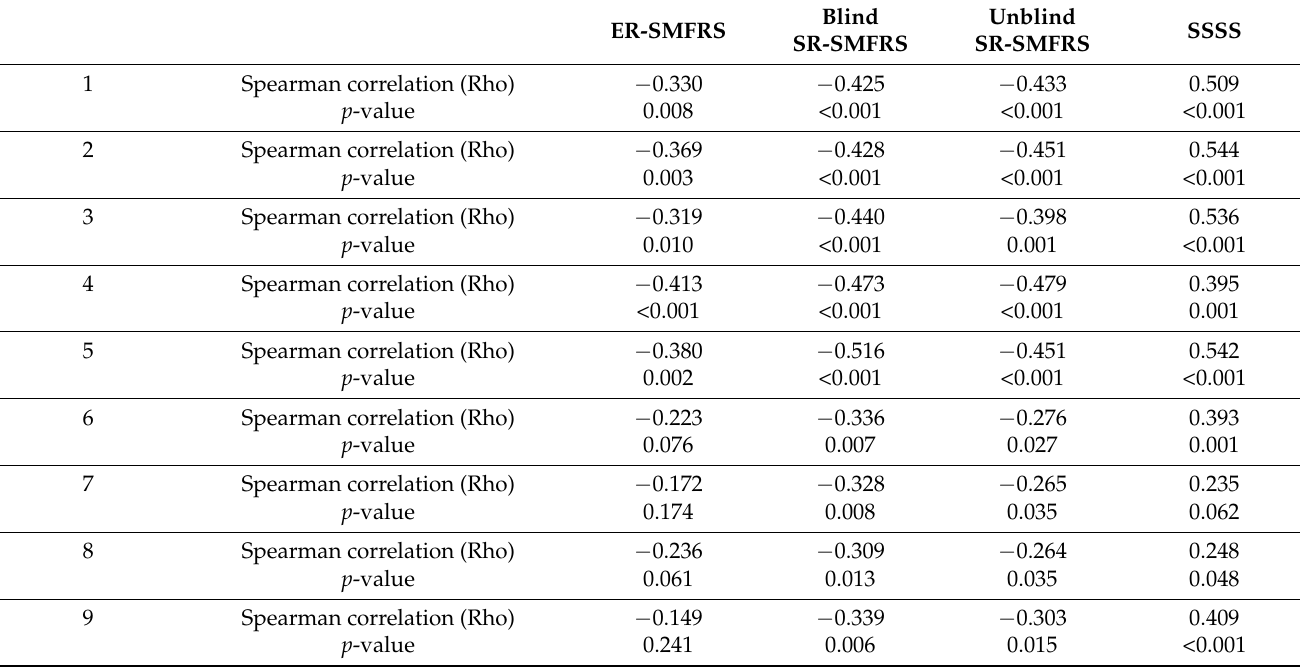
Table 10. Correlation of BIQLI with ER-SMFRS, blind SR-SMFRS, unblind SR-SMFRS, and